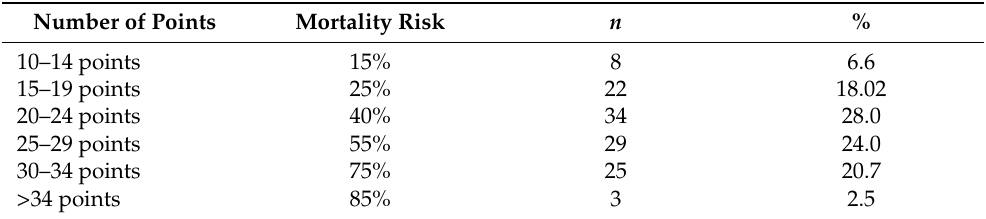
Table 2. Evaluation of the patients’ condition severity on admission to the ward based on the APACHE II